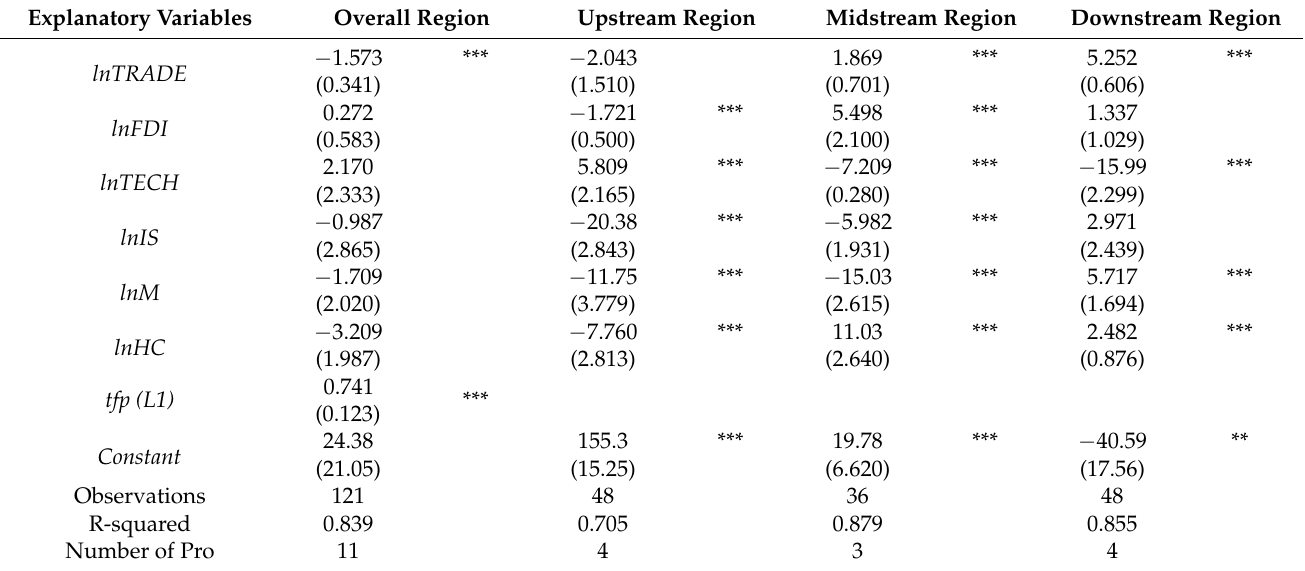
Table 4. Regression results of tfp influencing factors of the overall regions, upstream regions, mid- stream regions and downstream regions in the Yangtze River Economic